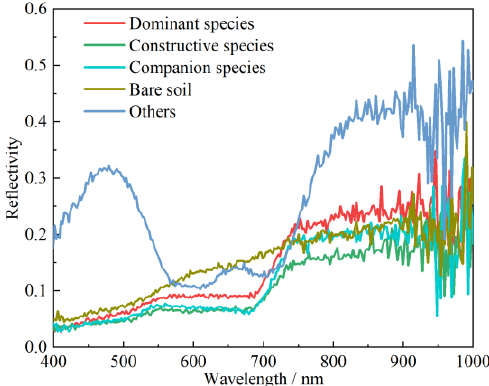
Figure 2. Spectral curve after reflectivity